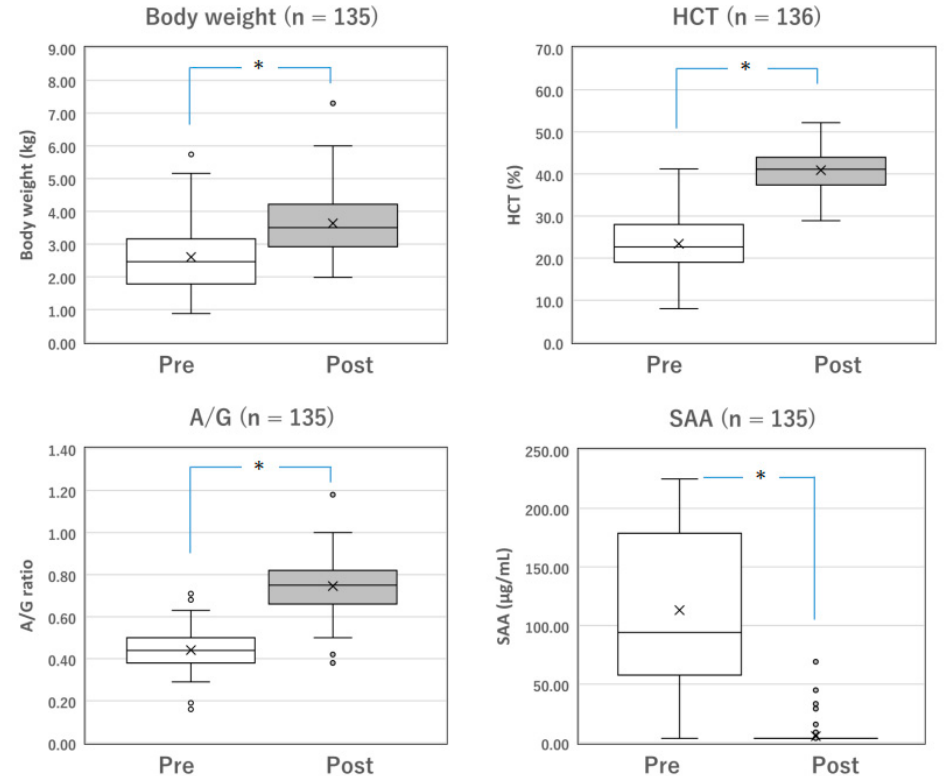
Figure 1. Changes in the parameters of surviving cats with mixed FIP before and after Mutian treatment. The body weight, HCT, and A/G of the surviving cats were significantly improved after Mutian therapy (Post) compared with their values at the initial examination prior to drug therapy (Pre) ( * p < 0.0001). In contrast, SAA levels were drastically decreased after therapy ( * p < 0.0001). The ‘×’ and the horizontal line in the box represent the mean and median, respectively. The median divides the box into interquartile ranges, and the box represents 50% of the data set, distributed between the 1st and 3rd quartiles. The whiskers show the outlier range outside the upper and lower quartiles. Open circles denote outliers. All statistical analyses were performed using the Wilcoxon signed-rank test (non-parametric). HCT, hematocrit; A/G, albumin-to-globulin ratio; SAA, serum amyloid-A.